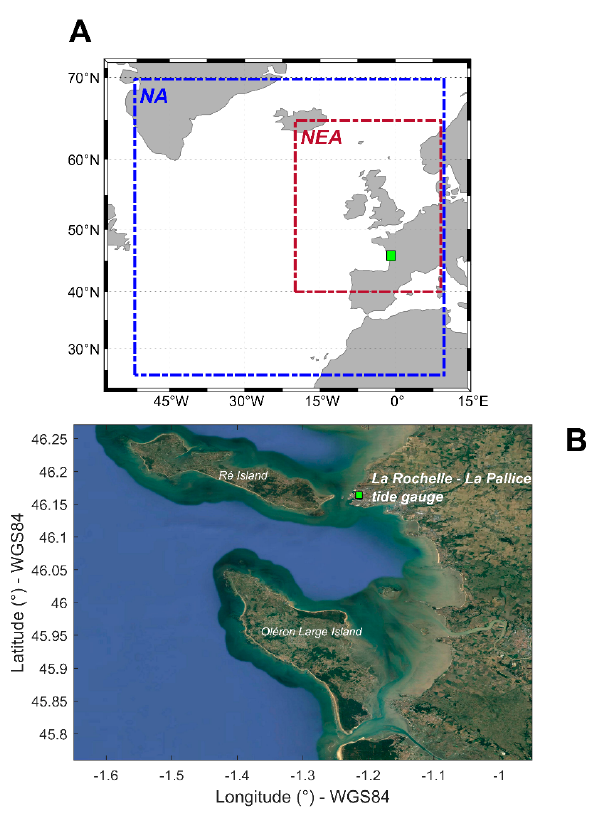
Figure 1. Study site: La Rochelle. ( A ) Study site location and North Atlantic domain (NA) and northeast Atlantic domain (NEA). ( B ) Regional setting. J. Mar. Sci. Eng. 2019 , 7 , x FOR PEER REVIEW